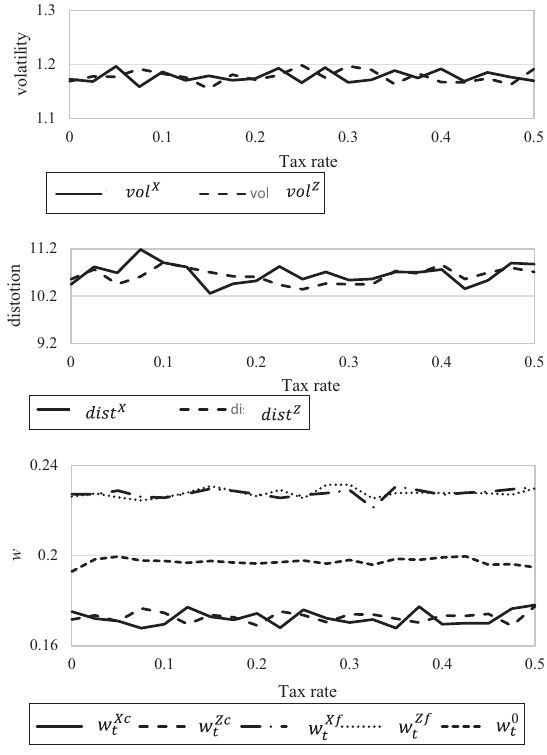
Figure 10. The impact of imposing taxes in market X on the dynamics of the